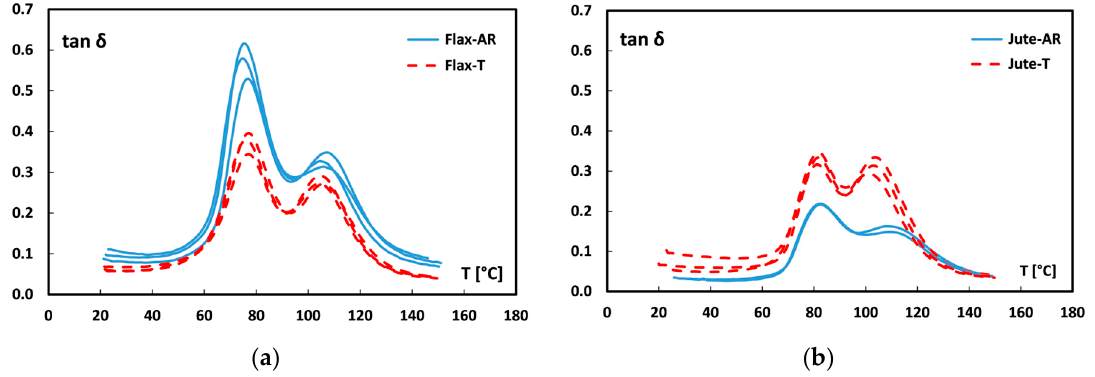
Figure 6. Damping factor curves of ( a ) flax and ( b ) jute monolithic laminates.